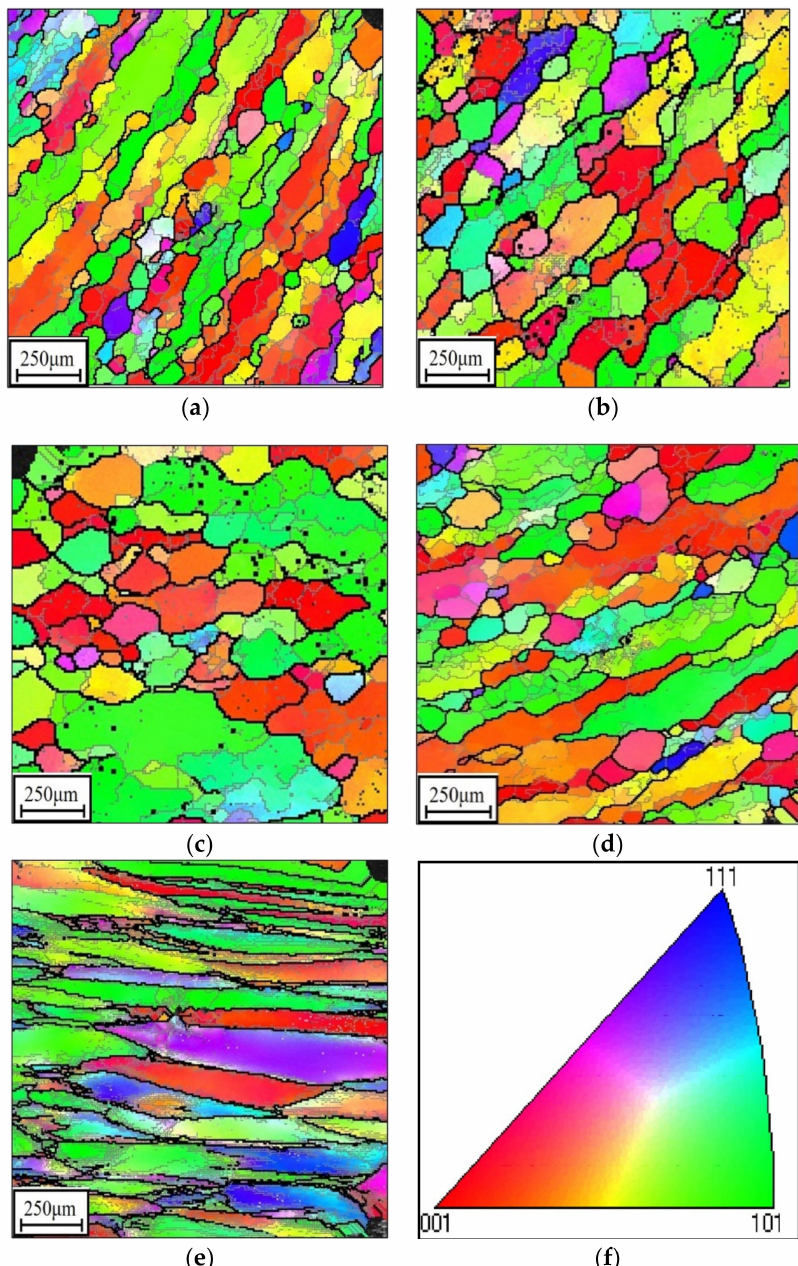
Figure 4. Orientation imaging microscopy maps of the investigated alloy at: ( a ) 890 ◦ C/0.1 s − 1 / ε I = 0.3/0.001 s − 1 , ( b ) 920 ◦ C/0.1 s − 1 / ε I = 0.3/0.001 s − 1 , ( c ) 950 ◦ C/0.1 s − 1 / ε I = 0.3/0.001 s − 1 , ( d ) 920 ◦ C/0.1 s − 1 / ε I = 0.9/0.001 s − 1 , ( e ) 920 ◦ C/0.1 s − 1 / ε I = 0.3/1 s − 1 , ( f ) IPF triangle